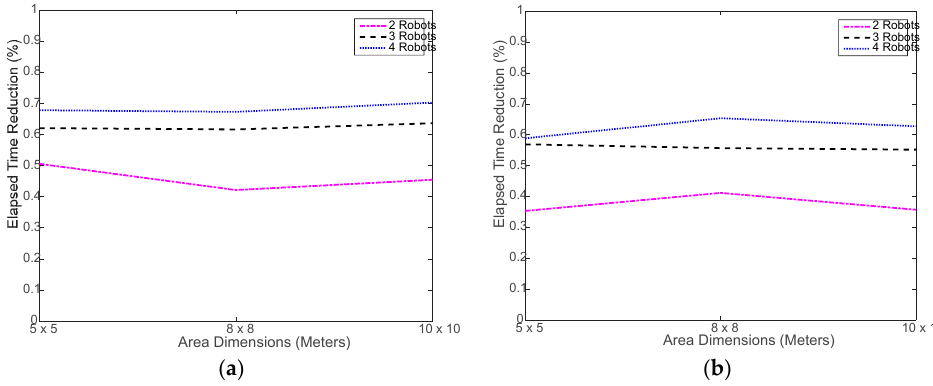
Figure 12. Simulated elapsed time reduction: ( a ) using distributed WiMAP algorithm; ( b ) using distributed DWiMAP.